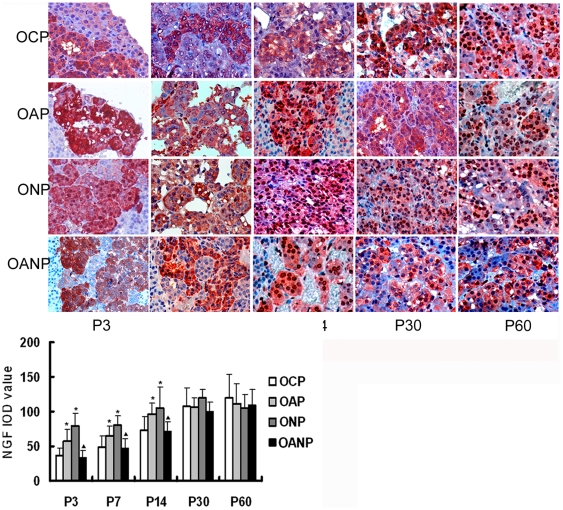
NGF immunochemistry in adrenal medulla of offspring rats.The expression of NGF increased in OAP and ONP rats adrenal medulla
compared to OCP rats from P3 to P14 and return to normal level from P30
to P60. The expressions of NGF protein in OANP rats decreased from P3 to
P14 compared to OAP. IOD values are expressed as mean
±SEM(n = 8); * P<0.05 vs. OCP,
▴<0.05 vs OAP. (The magnification of the image
is 400 ×).